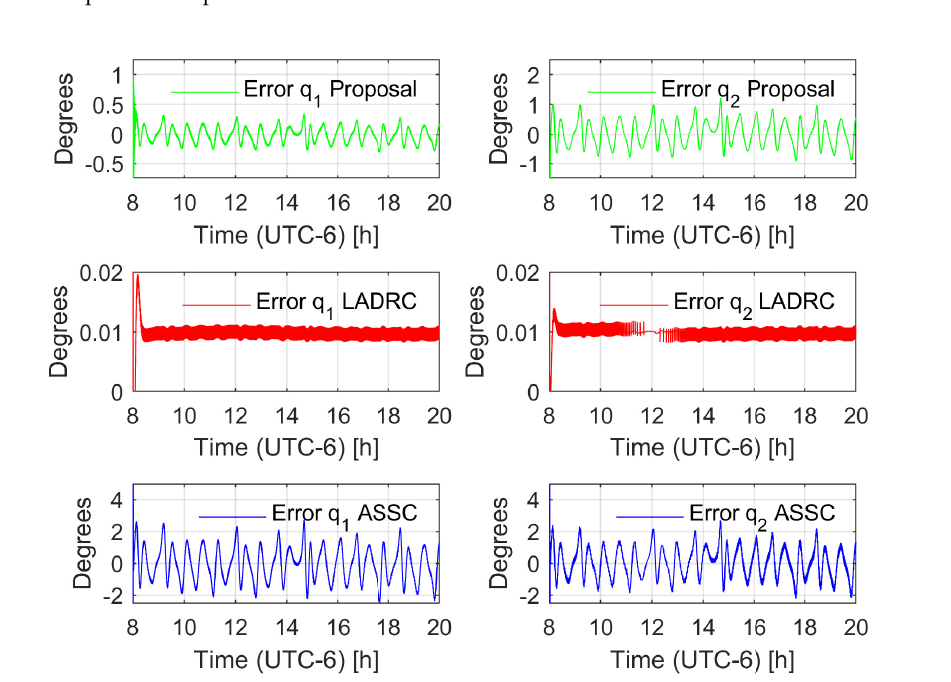
Figure 4. Tracking error behavior comparison (disturbed case) for azimuthal axis ( q 1 ) and elevation axis ( q 2 ). LADRC stands for linear active disturbance rejection control and ASSC for adaptive state space